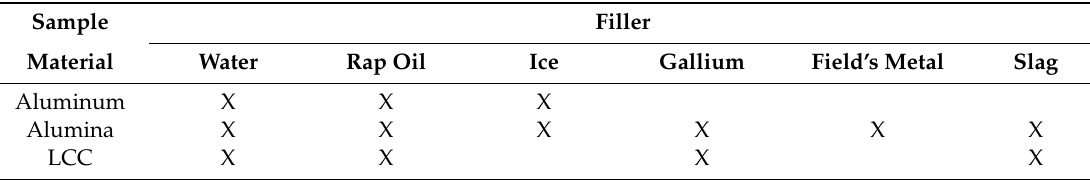
Table 1. Experimental matrix: combinations of material with